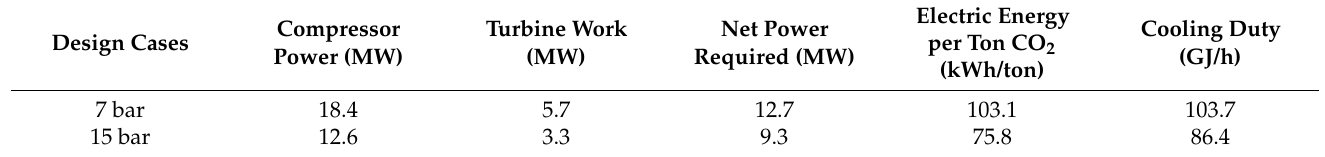
Figure 7. Process flow diagram for the open-cycle liquefaction design with a turbine and a valve.